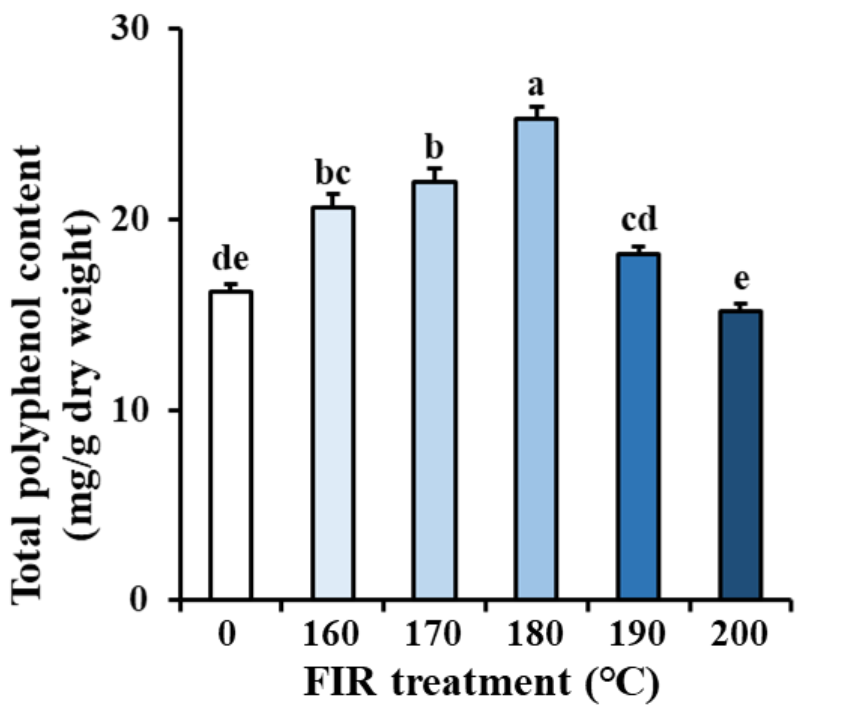
Figure 1. Changes in the total polyphenol content of ginseng leaves treated by FIR at different temperatures. The values are expressed as the mean with standard error ( n = 3). Different letters (a–e) above the bar graphs indicate significant differences at p < 0.05 on Tukey’s HSD test.